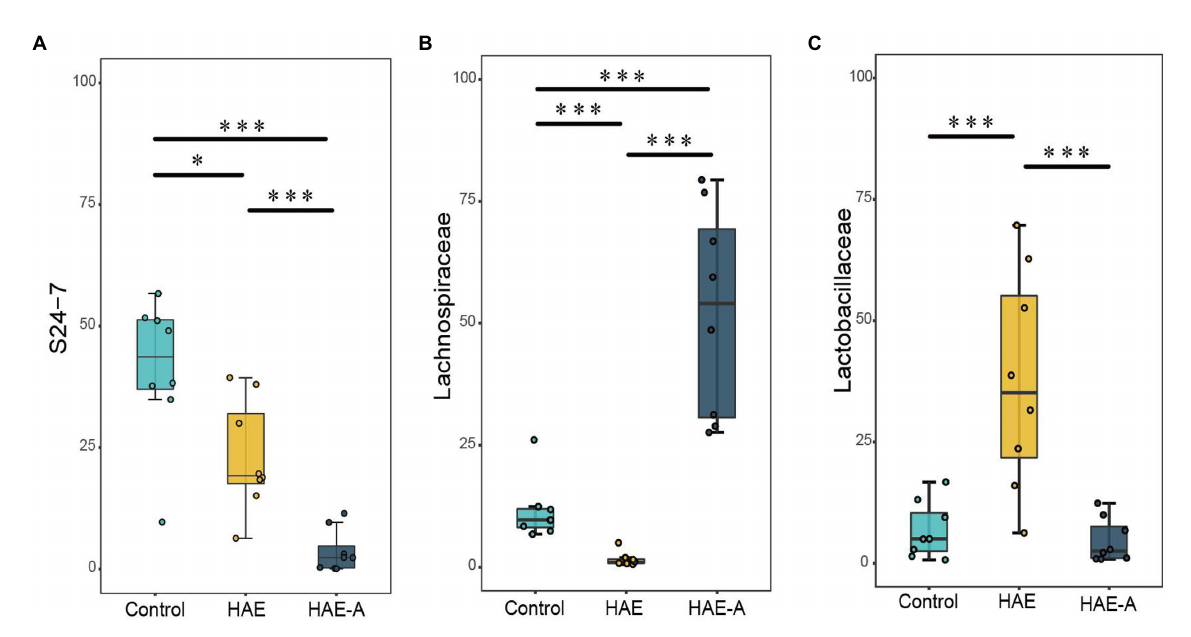
FIGURE 7 Significant altered bacterial taxa in colonic microbes by different treatments at family level. A–C : S24-7, Lachnospiraceae , and Lactobacillaceae , respectively. Boxplots showing differences in the relative abundance of significantly discriminant taxa between different treatments. Significance between groups was indicated with asterisk (* p < 0.05, ** p < 0.01, *** p < 0.001).